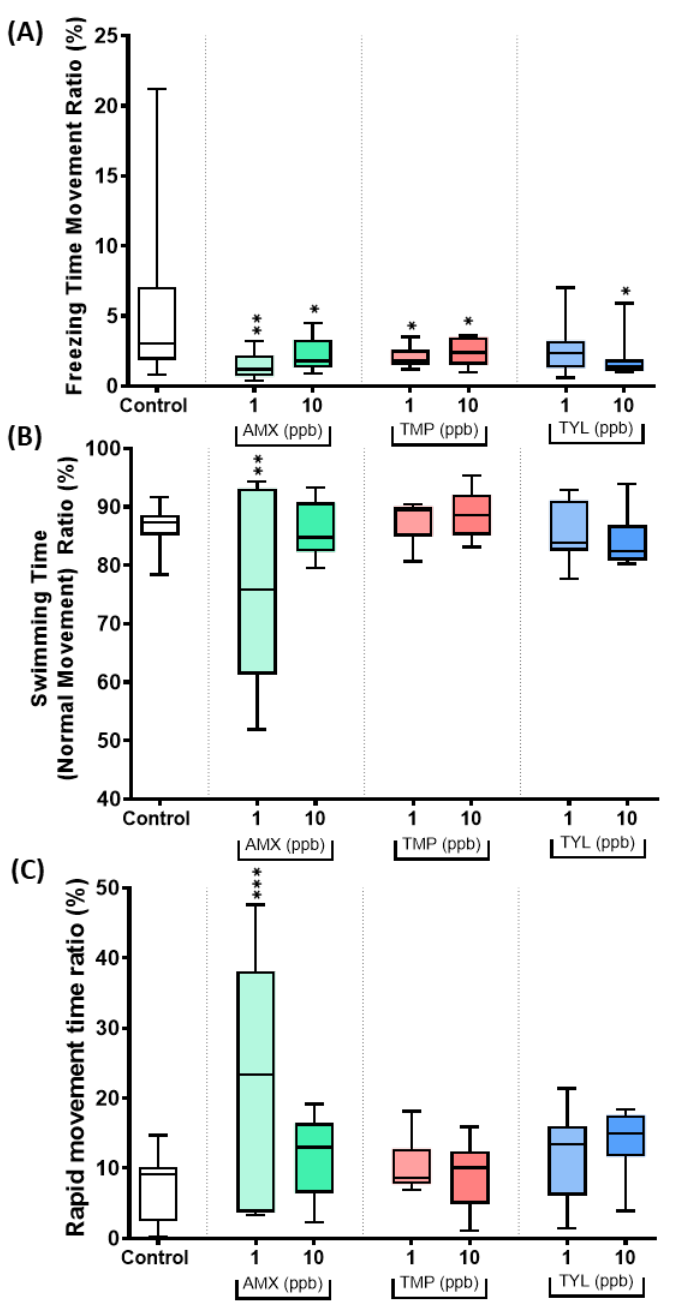
Figure A2. The motility (swimming) behavior of control and low-dose antibiotic-treated zebrafish after 10 days exposure. ( A ) Freezing time movement ratio (%); ( B ) swimming time normal movement ratio (%); and ( C ) rapid movement time ratio (%). Abbreviation: AMX, Amoxicillin; TMP, Trimethoprim; TYL, Tylosin. The data are expressed as mean ± S.E.M and were analyzed by ordinary one-way ANOVA followed by Dunnett’s test ( n control: 12, n for antibiotic groups: 12, except n for AMX 1 ppb and TMP 10 ppb: 11, and n TYL 10 ppb: 10). The significances were indicated by * p < 0.05; ** p < 0.01, and *** p < 0.001 when compared to control group.